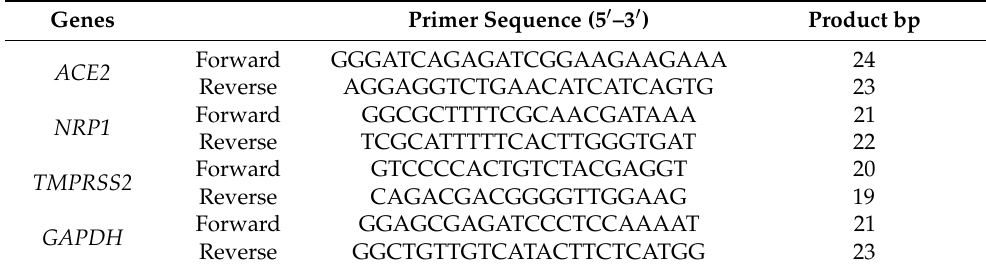
Table 2. Primer sequences used for real-time